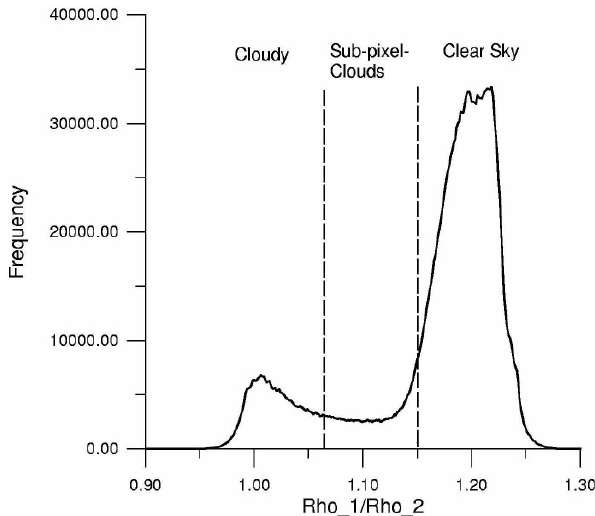
Fig. 10. Example of a histogram of the ratio R = ρ TOA (0.412µm)/ ρ TOA (0.443µm) of a real satellite scene. The ratio value, discriminating the clear sky range is used for cloud